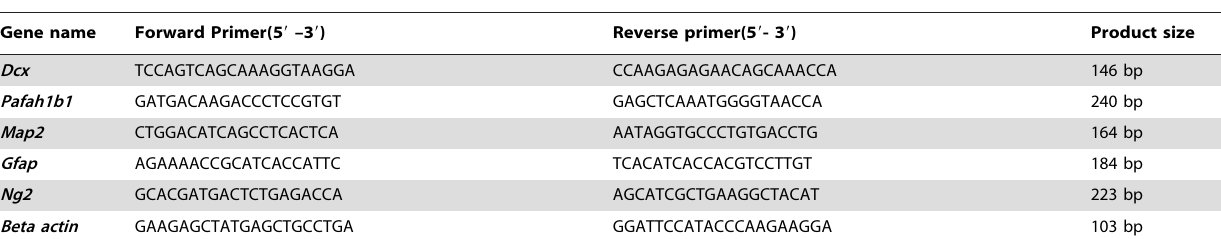
Table 1. Primers used for mRNA qRT-PCR.